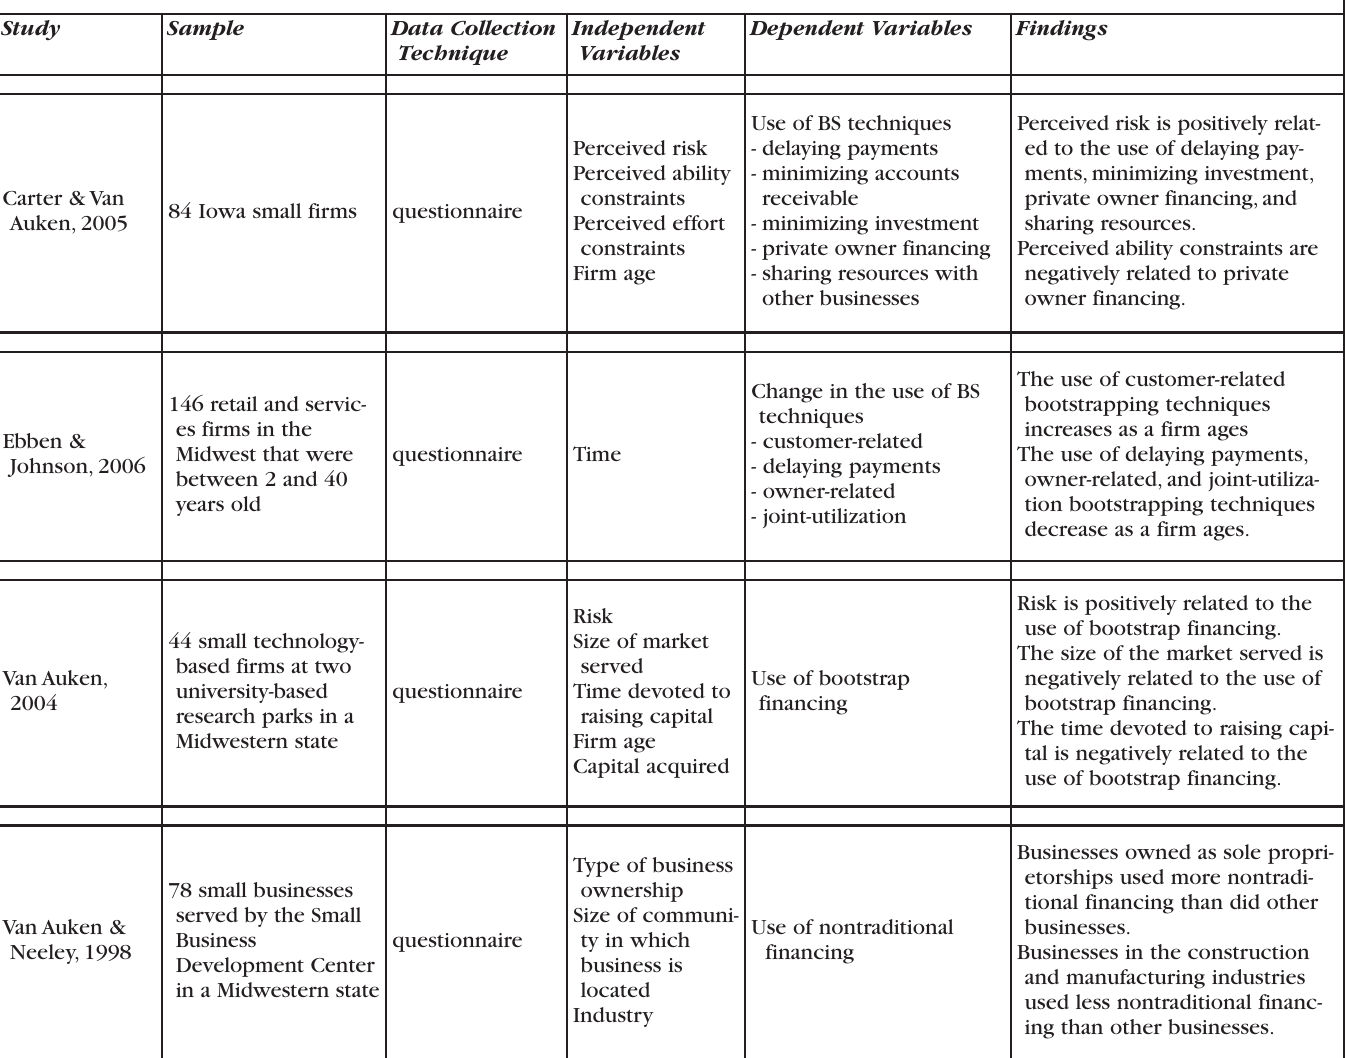
Table 1. Summary of Bootstrap Financing